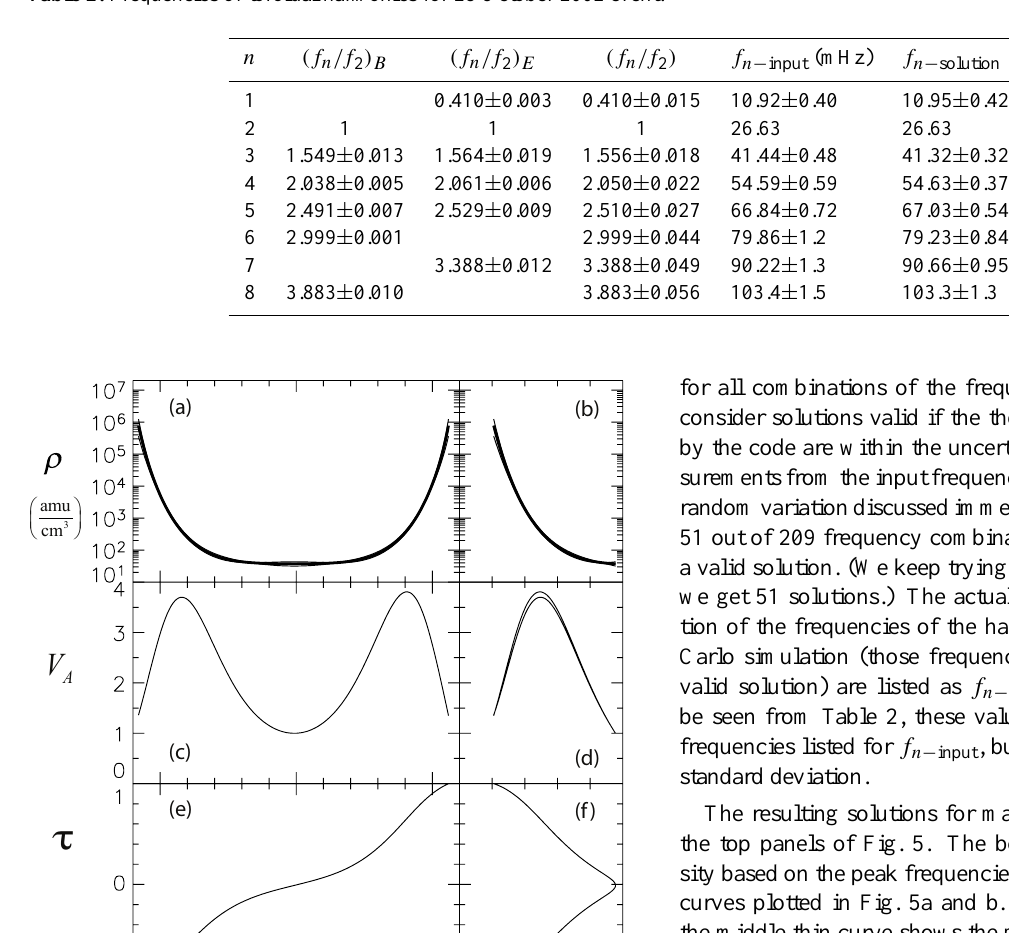
Table 2. Frequencies of toroidal harmonics for 28 October 2002 event.